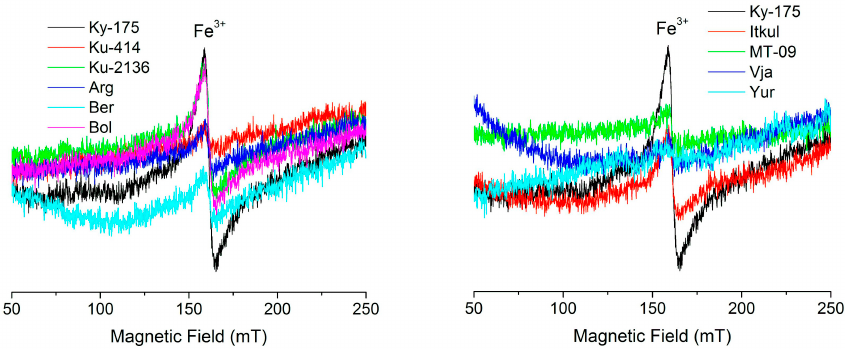
Figure 6. Electron paramagnetic resonance (EPR) spectra of investigated quartz samples taken at room temperature showing the weak rhombic Fe 3+ signal at g eff = 4.38; the intensities are given in arbitrary units.